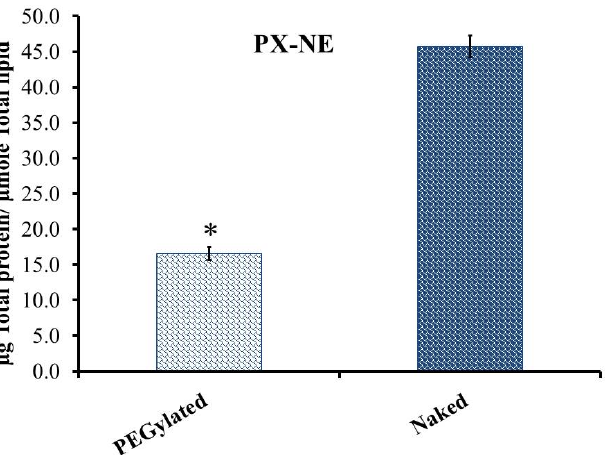
Figure 7. Total amount of serum proteins adsorbed on the surface of naked and PEGylated PX-NE. p < 0.05, compared with naked PX-NE.